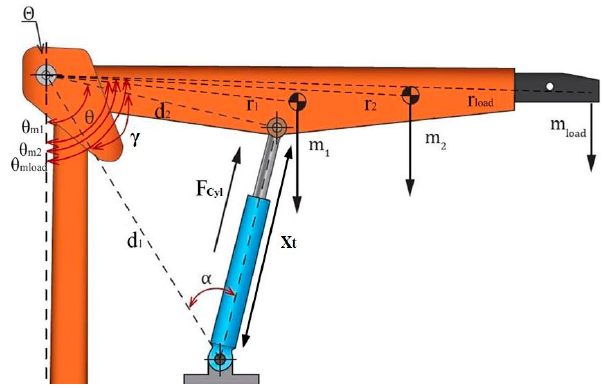
Figure 3. Free body diagram of the crane. (Adapted from [12]).